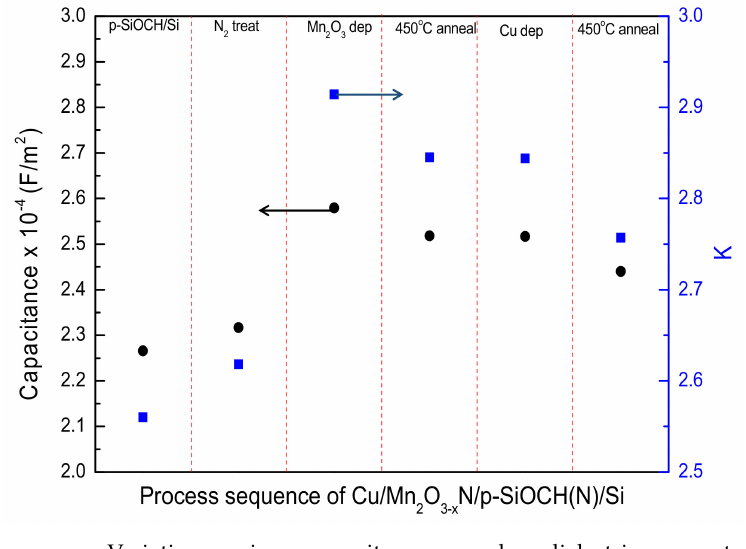
Figure 2. Variations in capacitance and dielectric constant during Cu / Mn 2 O 3 − x N / p-SiOCH(N) / Si